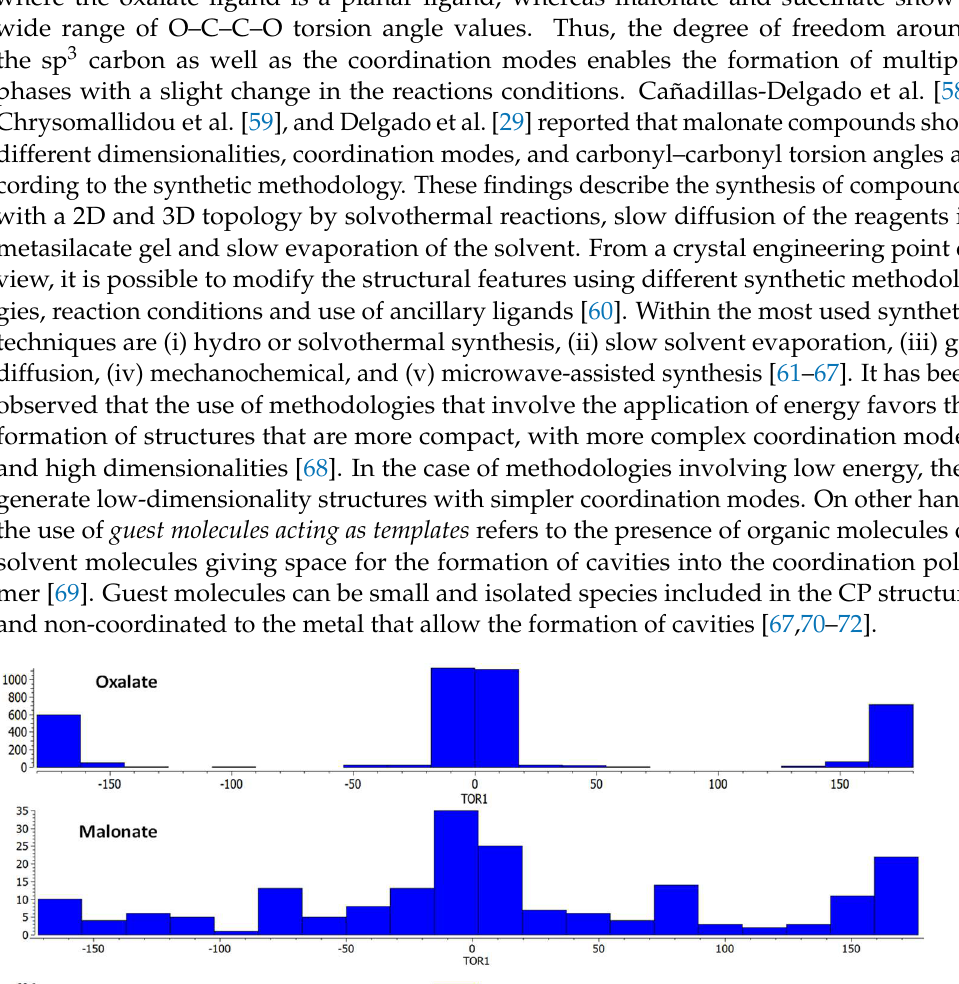
Figure 4. Typical coordination modes observed in ditopic aliphatic ligands. (CH 2 ) n